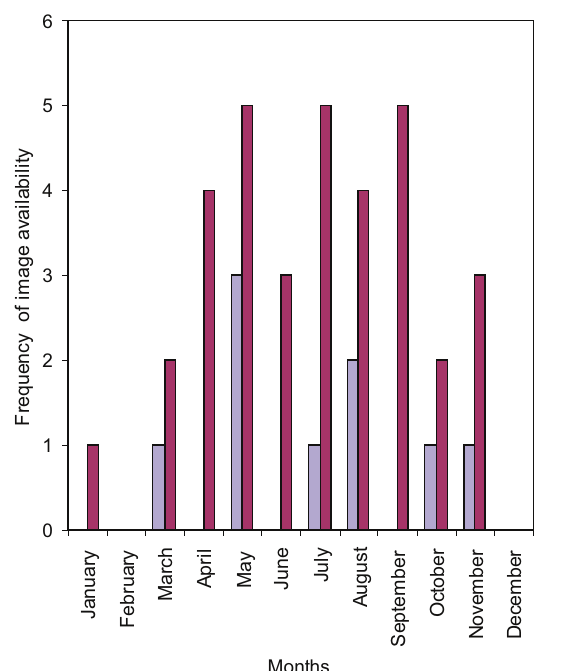
Fig. 9. Frequency of numbers of total and cloud-free image availability in Risley